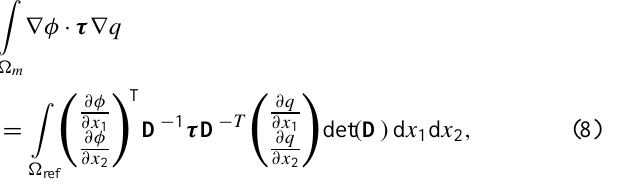
Figure 1. A cubed-sphere